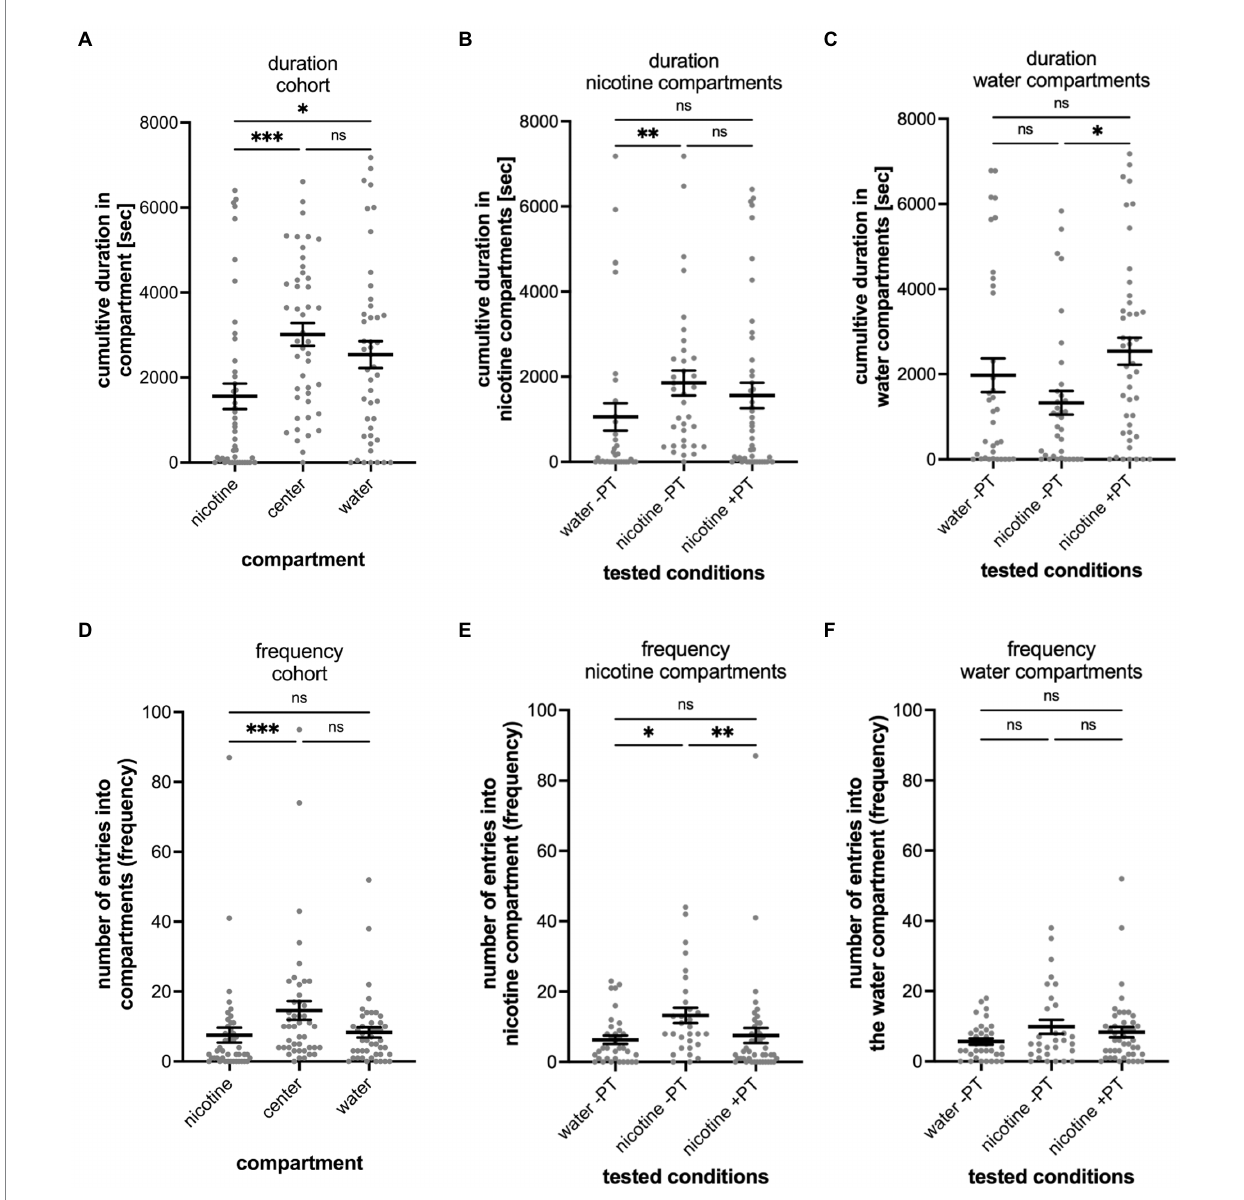
FIGURE 5 Shows the results of nicotine pre-treatment (PT) experiments. (A) The results of the entire tested cohort ( n = 45) are shown for the cumulative duration spent in compartments and the number of entrances into compartment (frequency; D). (B) Compares the durations spent in the nicotine compartment under different experimental conditions including water controls without nicotine pretreatment when water was added to the “nicotine compartment” (water -PT, n = 35), at a 0.63 μ M nicotine concentration in the nicotine compartment without nicotine pretreatment (nicotine -PT, n = 30), and at 0.63 μ M nicotine in the nicotine compartment with a 1 μ M nicotine pretreatment (nicotine +PT, n = 45). The cumulative duration increased in nicotine without pre- treatment compared to water ( p = 0.0014) but did not change with nicotine-pretreatment ( p = 0.1124). (C) Comparison of the cumulative time spent in the water compartment under the indicated experimental conditions as in (B) (water –PT, nicotine –PT, and nicotine +PT). Nicotine pre-treatment increased the duration spent in the water compartment ( p = 0.0287). (D) The results of the entire tested cohort ( n = 45) are shown for the number of entrances into the nicotine, center, and water compartments (frequency). The number of entrances into the nicotine compartment (nicotine) were lower compared to the entrances into the center compartment ( p = 0.0008). Entrances into the water compartment compared to the center compartment were not significantly different ( p = 0.0851). (E) Comparison of the number of entrances (frequency) into the nicotine compartment under the same indicated condition as in (B) (water –PT, nicotine –PT, and nicotine +PT). The number of entrances increased ( p = 0.0175) when nicotine was added into the nicotine compartment without nicotine pre-treatment (nicotine –PT) compared to water controls (water –PT) but not with a nicotine pretreatment (nicotine +PT) ( p = 0.3816). Nicotine pretreatment reduced the number of entrances into the nicotine compartment (nicotine +PT) when compared to the nicotine without nicotine pretreatment (nicotine -PT) ( p = 0.0036). (F) Entrances into the water compartment under the three different experimental conditions (water –PT, nicotine –PT, and nicotine +PT) were not significantly different. Individual data points are shown with means ±SEM. Statistical significance was tested using a Kruskal–Wallis test with Dunn’s comparison test. *** p < 0.0008; ** p < 0.0036, * p < 0.0364; ns >